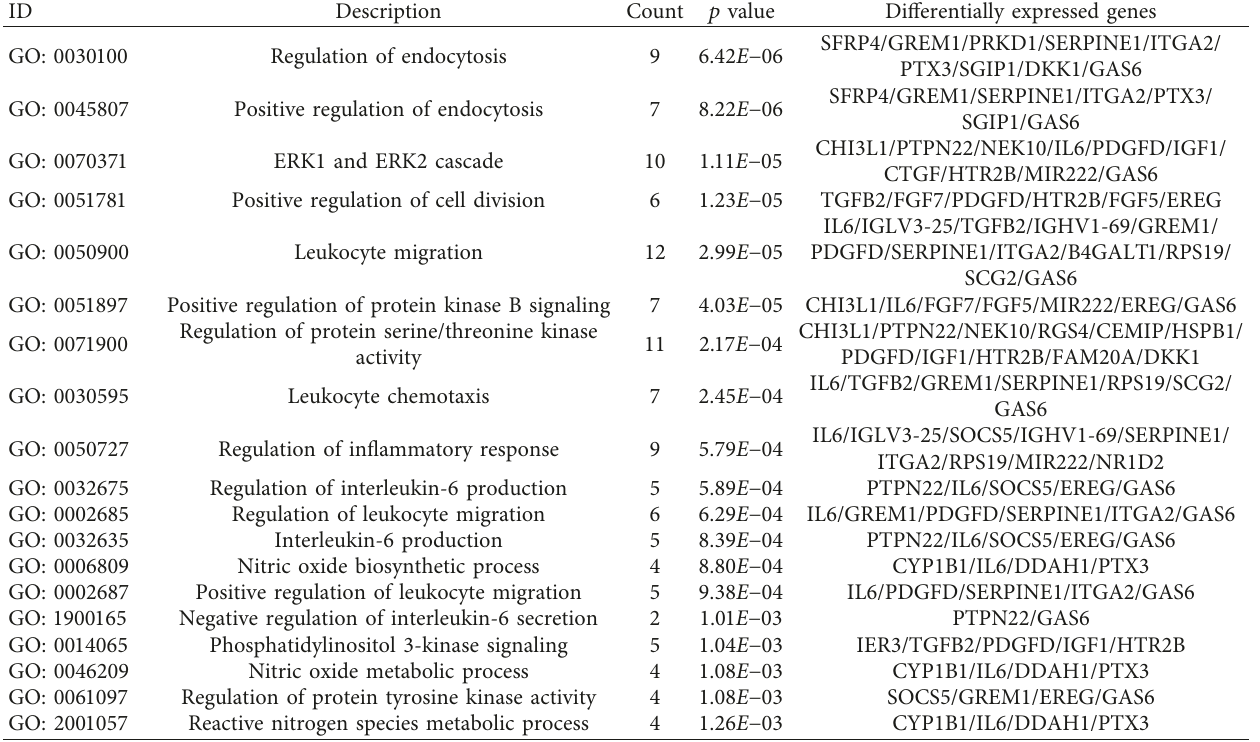
Figure 2: Filtering of probe sets to identify differentially expressed genes in OEG, V1, InG, and V2. We investigated the transcriptome changes with Affymetrix HTA 2.0 microarrays containing 70753 probe sets. If they showed t test p value < 0.05 and a fold change < − 2.0 or > 2.0, the genes were considered differentially expressed. 107 and 599 probe sets were filtered with these criteria in OEG compared with V1 and InG compared with V2, respectively. The table is giving the numbers of upregulated or downregulated and coding or noncoding transcripts. OEG: GNPDA2 overexpressed ADMSCs; V1: the control cells of OEG; InG: GNPDA2 shRNA knockdown ADMSCs; V2: the control cells of InG. (a) OEG vs. V1. (b) InG vs. V2. Table 1: GO biological processes enrichment analysis results (OEG vs.